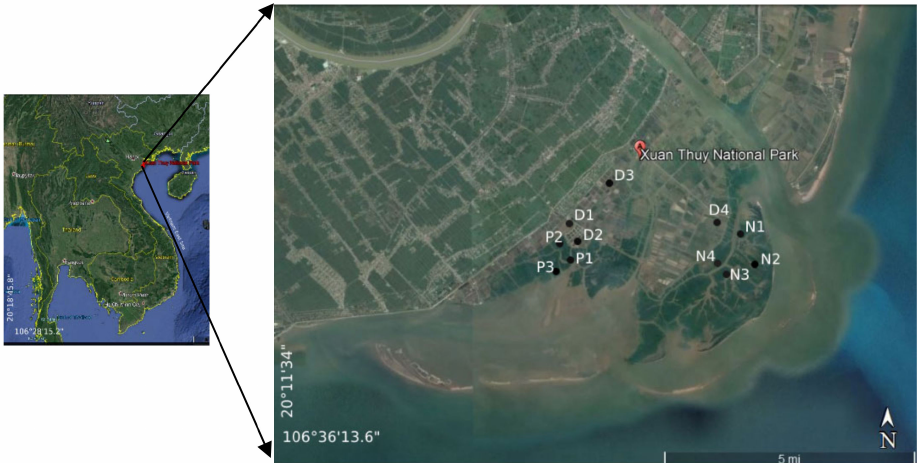
Figure 1. Location of the mangroves study area. The monitoring sites N: natural; D: Deforested; P: